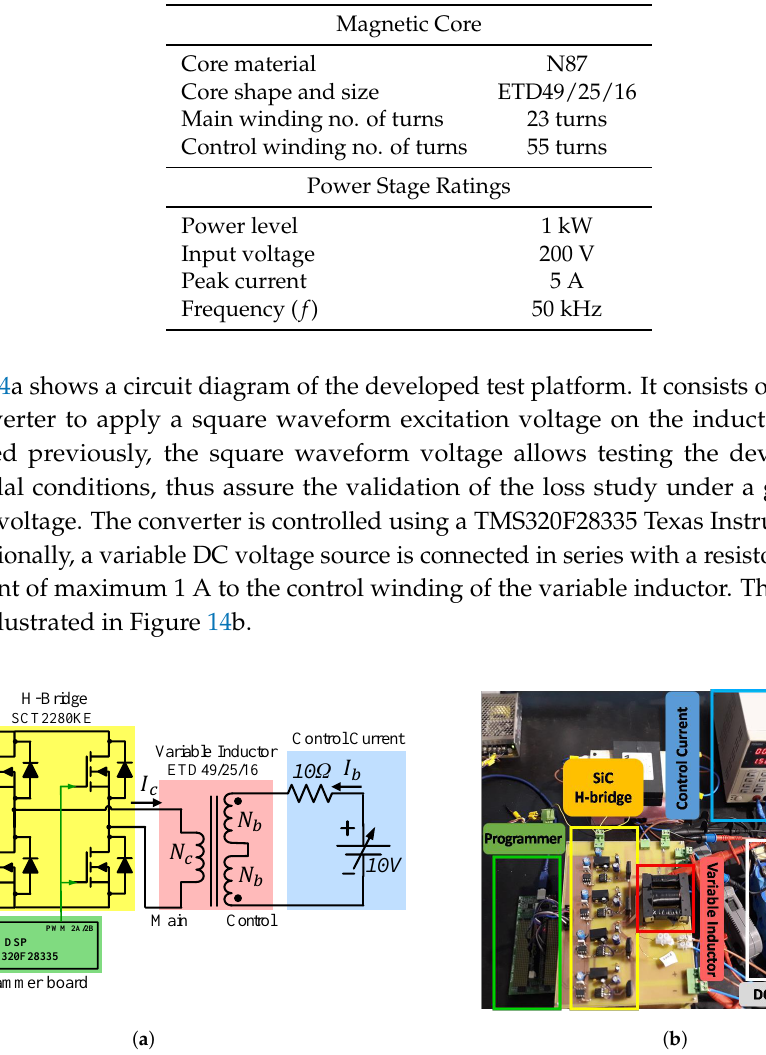
Figure 13. Variable inductor prototype based on double the E-core structure. Table 5. Specifications of the test setup developed to validate the full VI model.